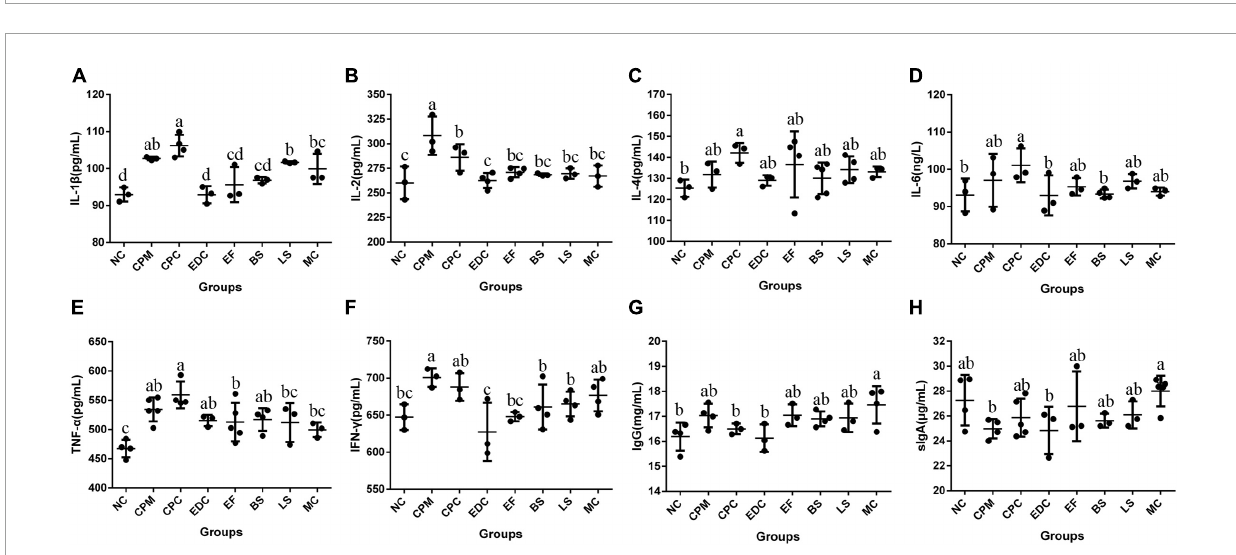
FIGURE7 Cytokine and immunoglobulin levels after different treatments ( n = 6). (A–H) Protein content of serum IL-1 β , IL-2, IL-4, IL-6, TNF- α , IFN- γ , IgG, and intestine sIgA in mice. a-c means those with different letters are significantly different ( P < 0.05).